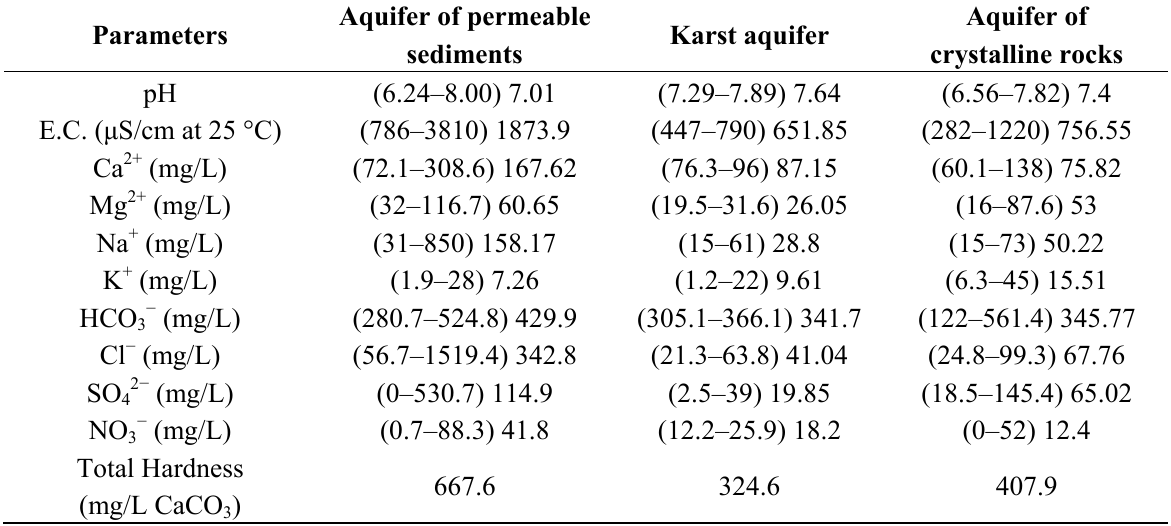
Table 2. Summary statistics for concentrations of groundwater samples (min-max and mean value) from 34